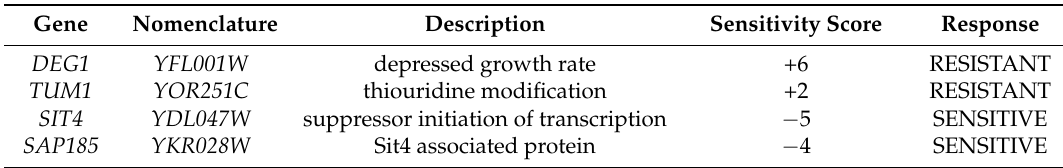
Table 1. Soraphen A responses of tRNA modification and phosphatase mutants. Data were obtained from a soraphen A screening of a deletion library [33].